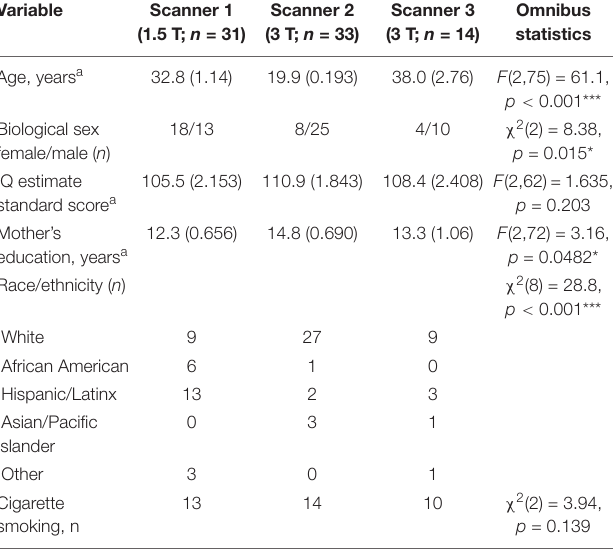
TABLE 1 | Demographics of participants tested on different